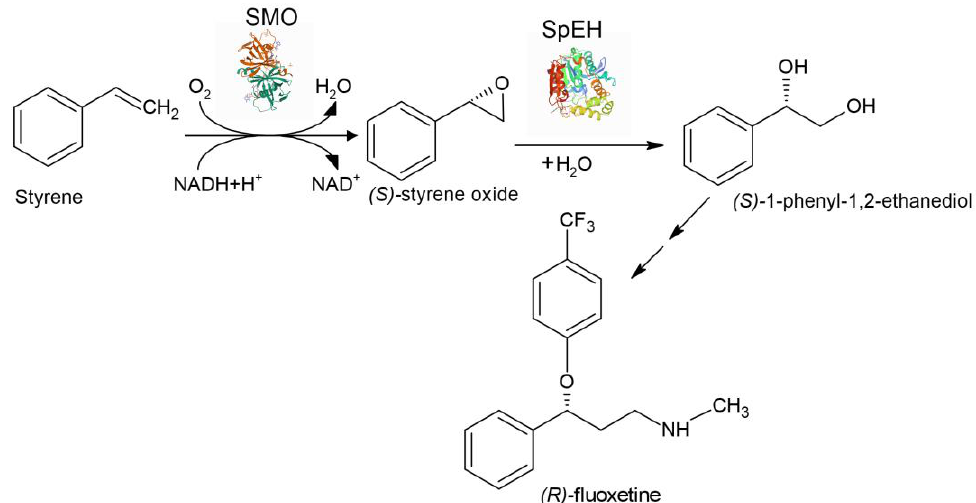
Figure 2. An example of a non-natural enzyme cascade consisting of two steps, including styrene monooxygenase (SMO) in the form of resting E. coli cells and epoxide hydrolase (SpEH) as a cell- free extract for the production of (S)- 1-phenyl-1,2,ethanediol [152] as an intermediate for synthesiz- extract for the production of ( S )-1-phenyl-1,2,ethanediol [152] as an intermediate for synthesizing the ing the pharmaceutical (R)- fluoxetine [153] . pharmaceutical ( R )-fluoxetine [153].